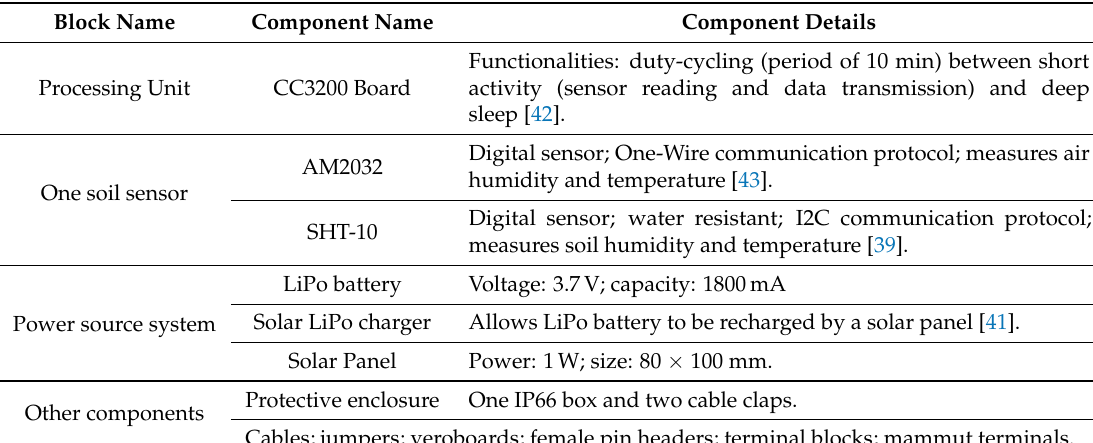
Table 4. Greenhouse module INs: building blocks and selected